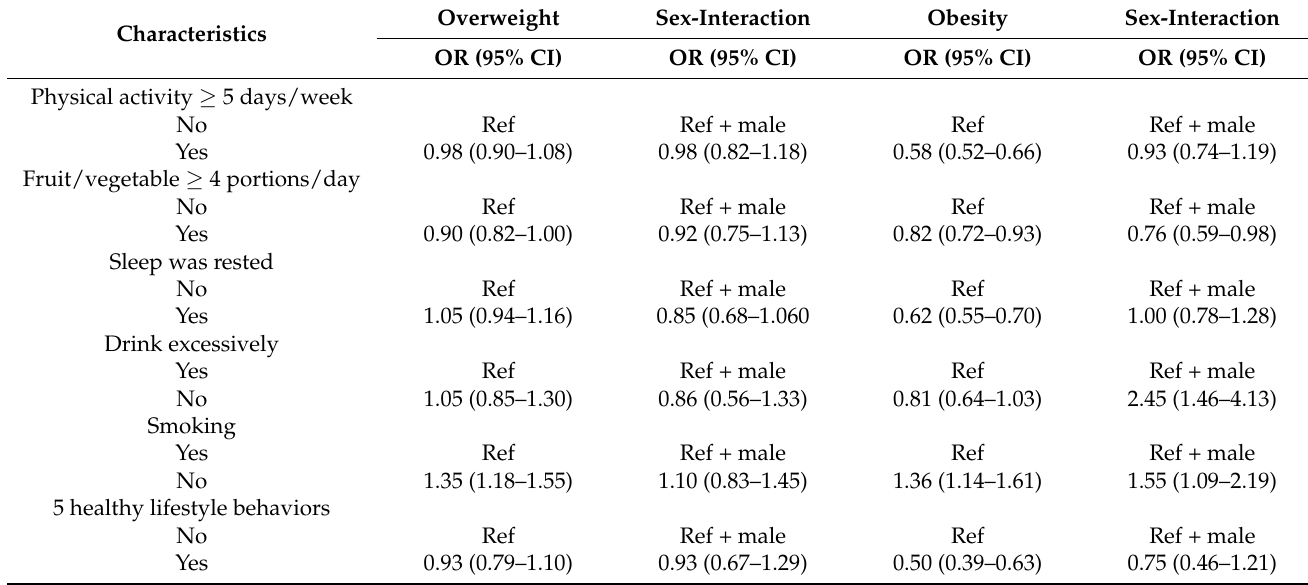
Table 3. Adjusted odds ratios for the relationship between health behaviors with overweight and obesity among adults >65